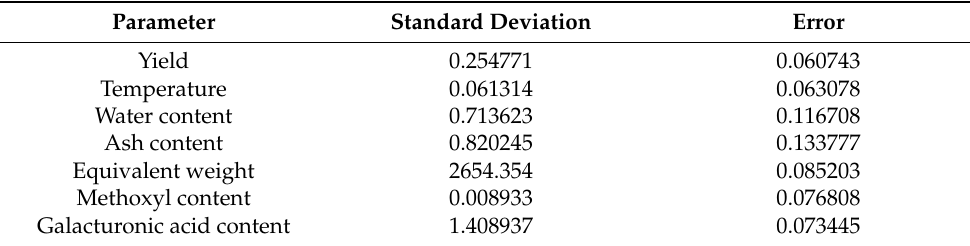
Table 1. Standard deviation and error of model equation.